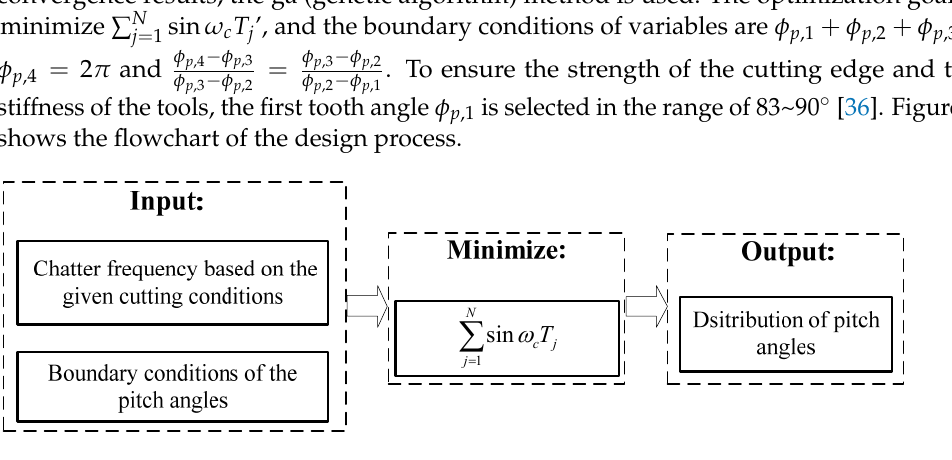
Figure 3. Flowchart of optimizing variable pitch angles.